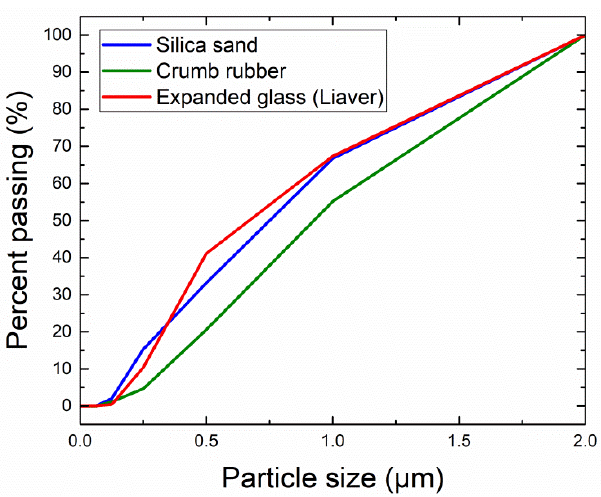
Figure 1. Grading curves of the applied aggregates.